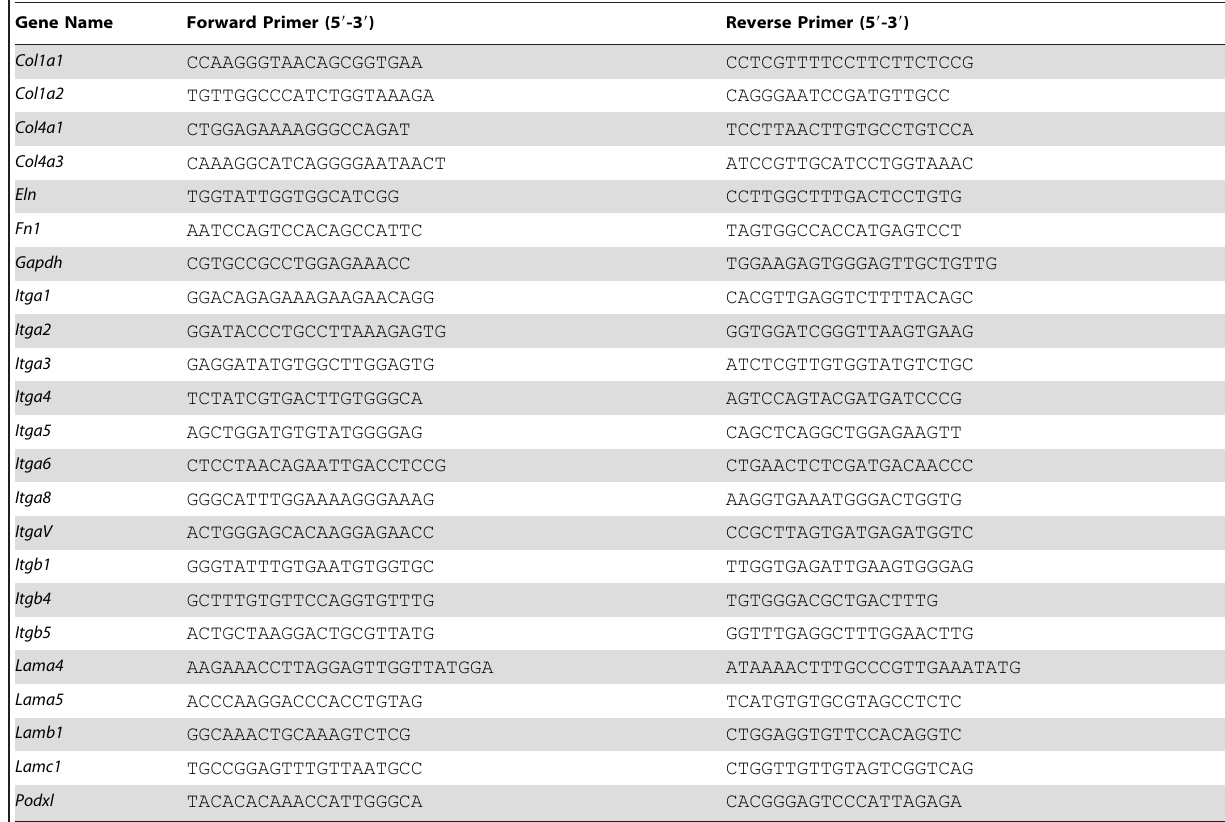
Table 1. Real time qPCR primer